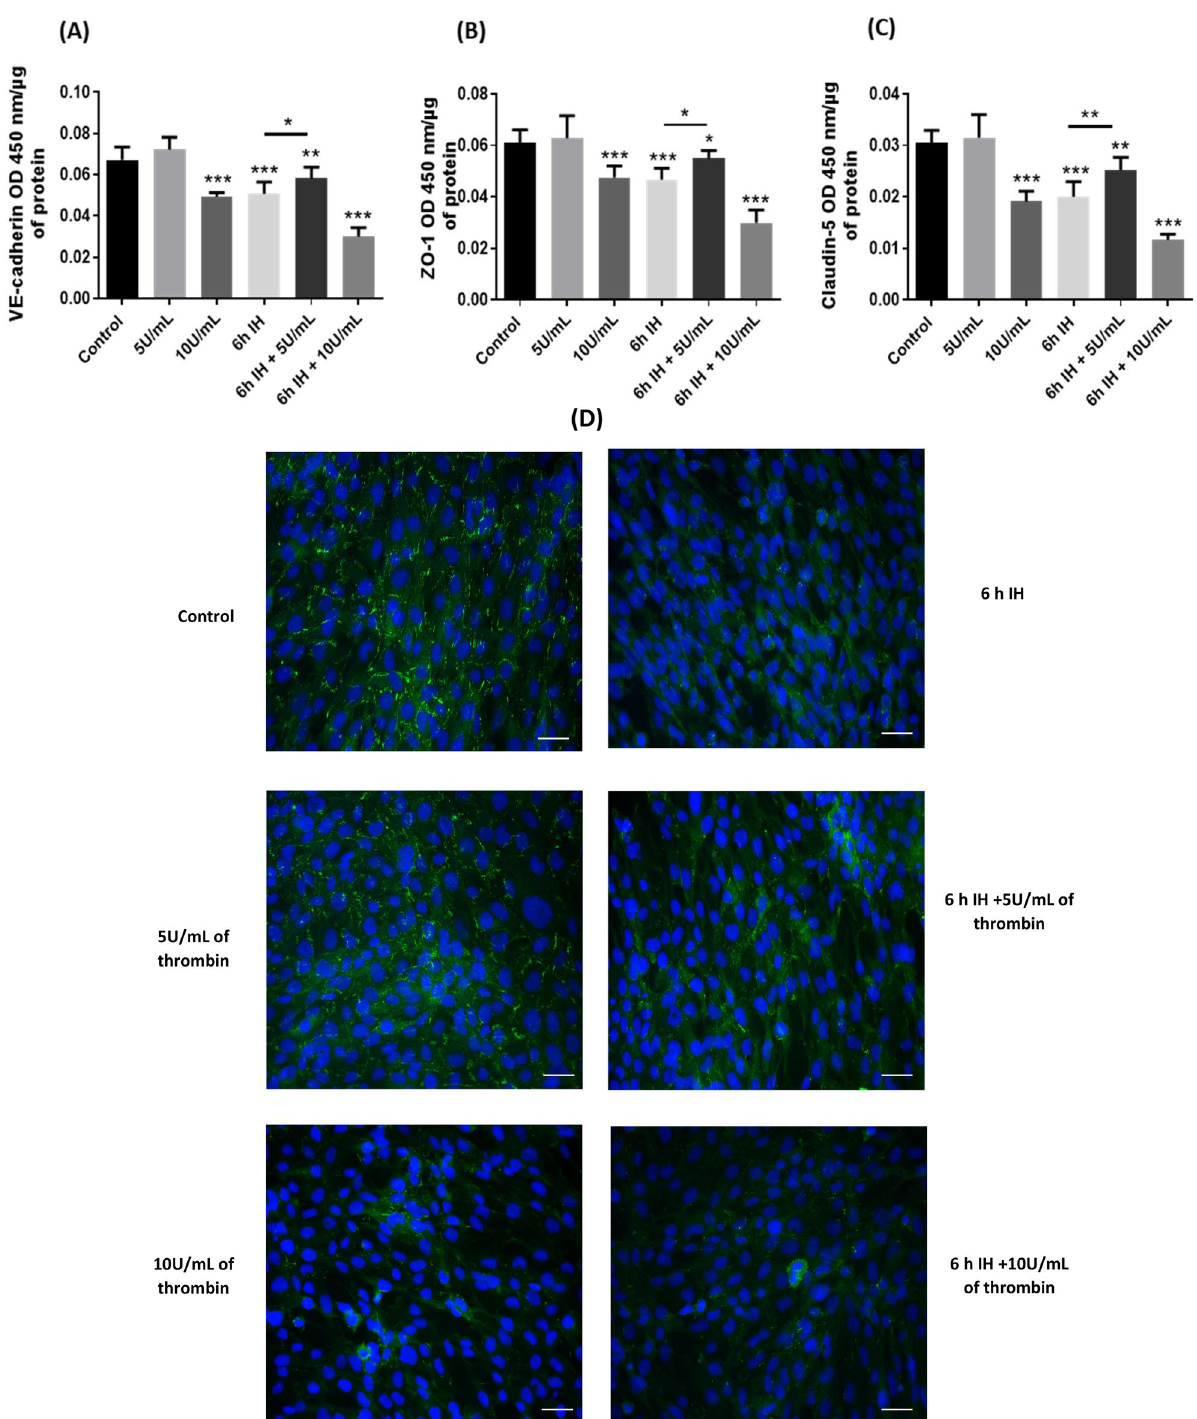
Figure 2. Expressions of VE-cadherin ( a ), ZO-1 ( b ) and claudin-5 ( c ) after exposure of cells in our different conditions. For treatment with thrombin, cells were exposed to thrombin at 5 or 10 U/mL for 1 h. Then cells were also exposed to 6 h of IH alone or associated with thrombin at 5 or 10 U/mL during the last hour. Immunostaining of ZO-1 after exposure of cells to our different treatments in our model of blood–brain barrier ( d ) Scale bar = 100 µm. Results are represented as mean value ± SD ( n = 9, N = 3), * p ≤ 0.05, ** p ≤ 0.01, *** p ≤ 0.001 compared to control